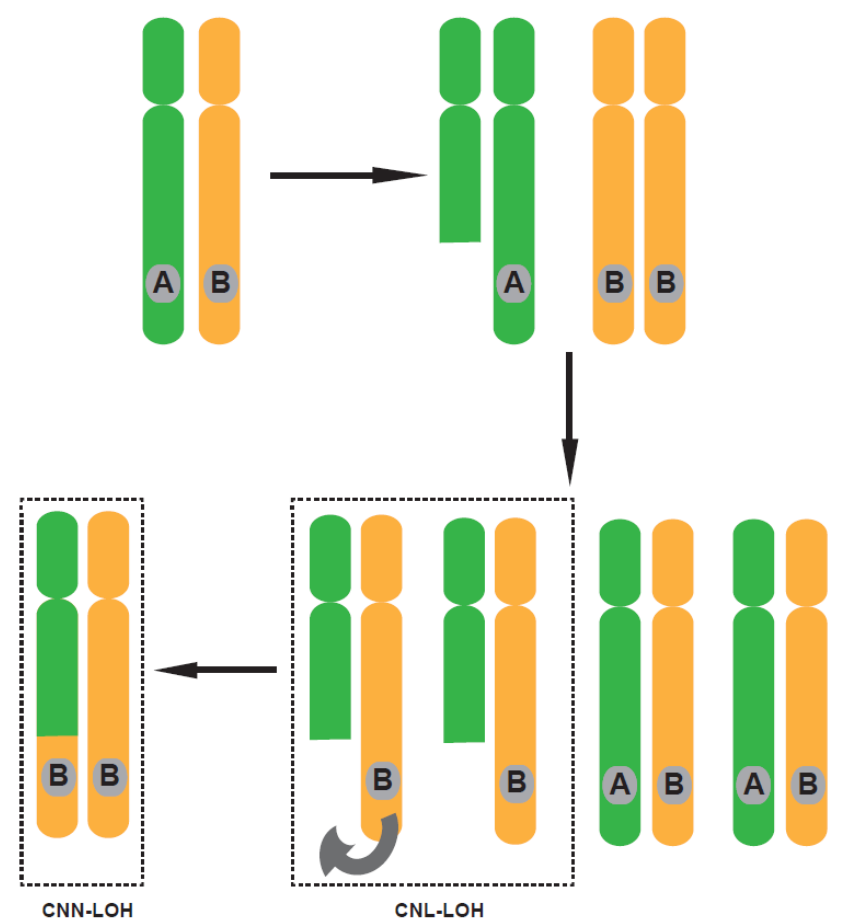
Figure 1. Two types of loss of heterozygosity. There are two main types of loss of heterozygosity (LOH), LOH with copy number losses (CNL-LOH) and copy number neutral LOH (CNN-LOH). Mitotic recombination is considered a major contributor to acquired LOH. During cancer progression, tumor cells may lose one allele (here referred to as A) as a consequence of partial chromosome deletion which is defined as LOH with copy number losses (CNL-LOH). CNL-LOH could further undergo recombination using the homolog (here refers as allele B) as a template for correction which is defined as LOH with copy number neutral (CNN-LOH). Here, orange and green regions represent either of two homologous chromosomes.